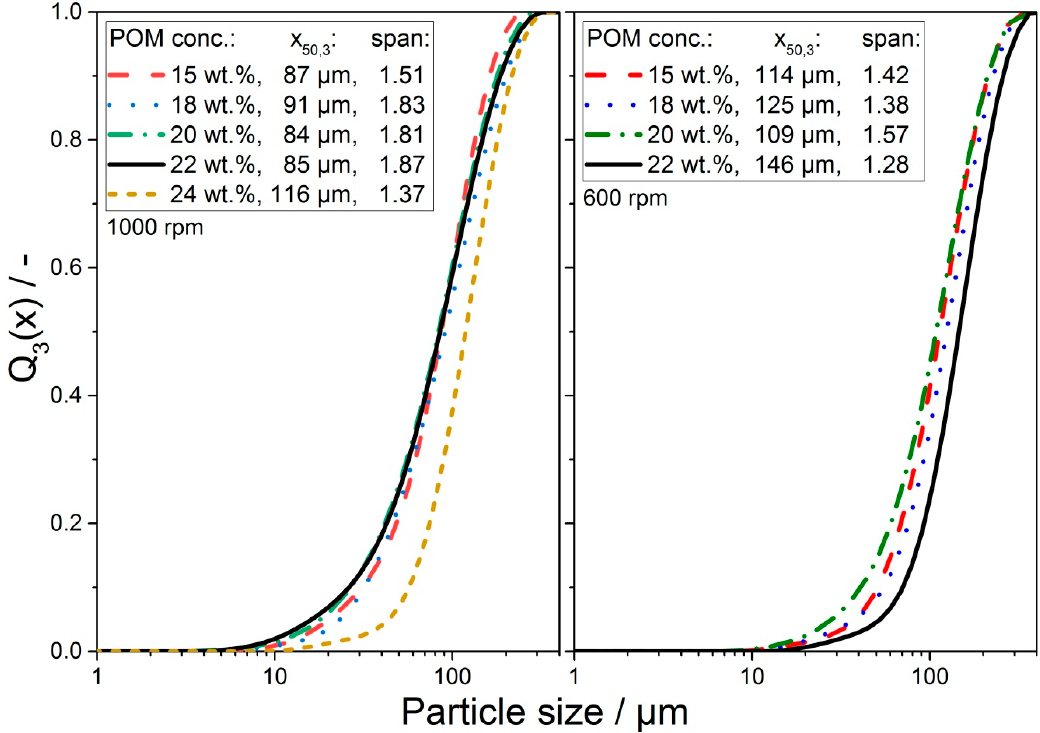
Figure 4. Volume weighted cumulative particle size distributions of POM particles precipitated from acetophenone (left) at 1000 rpm and triacetin (right) at 600 rpm with POM concentrations varying between 15 wt.% and 24 wt.%. Additionally given are the mean particle size x 50,3 and the span.